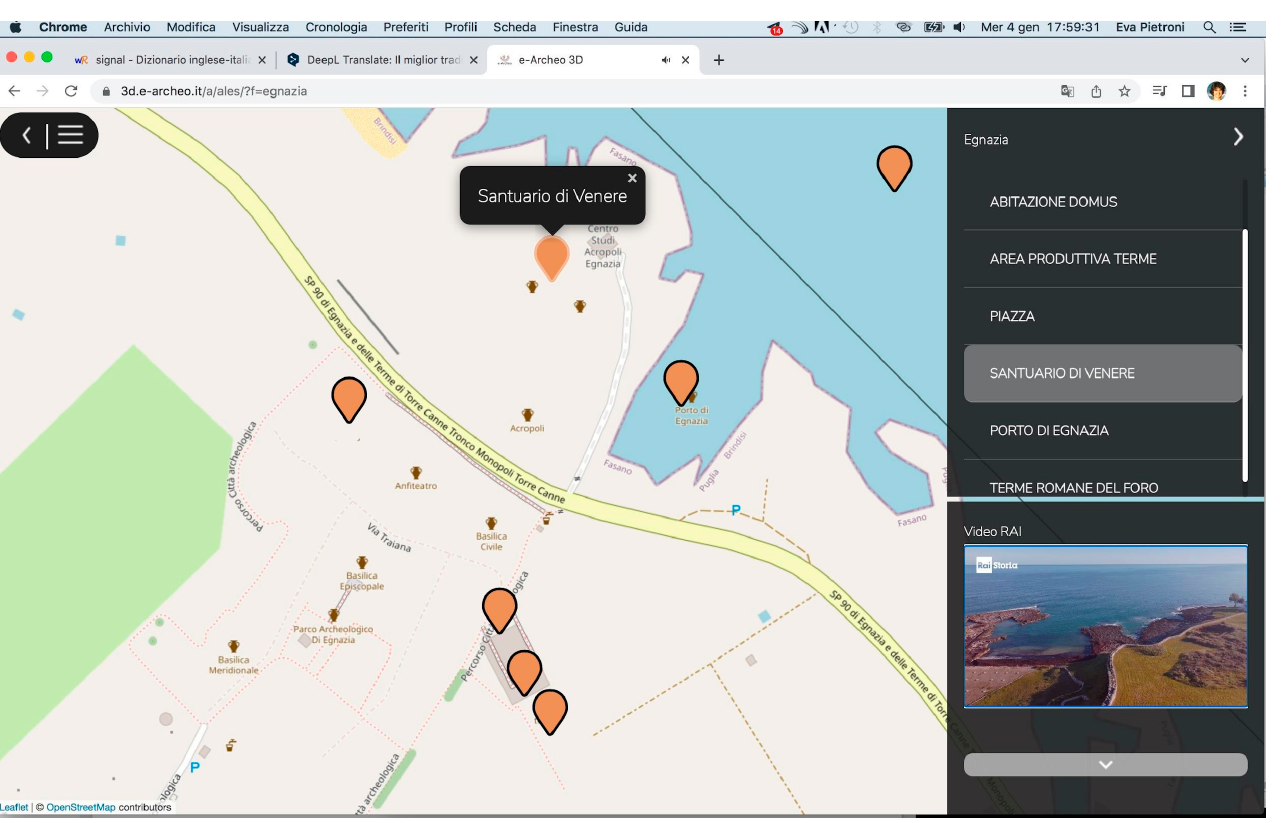
Figure 4. e-Archeo 3D web app; the map is the main interface to select contexts in the archaeological site and access related content.